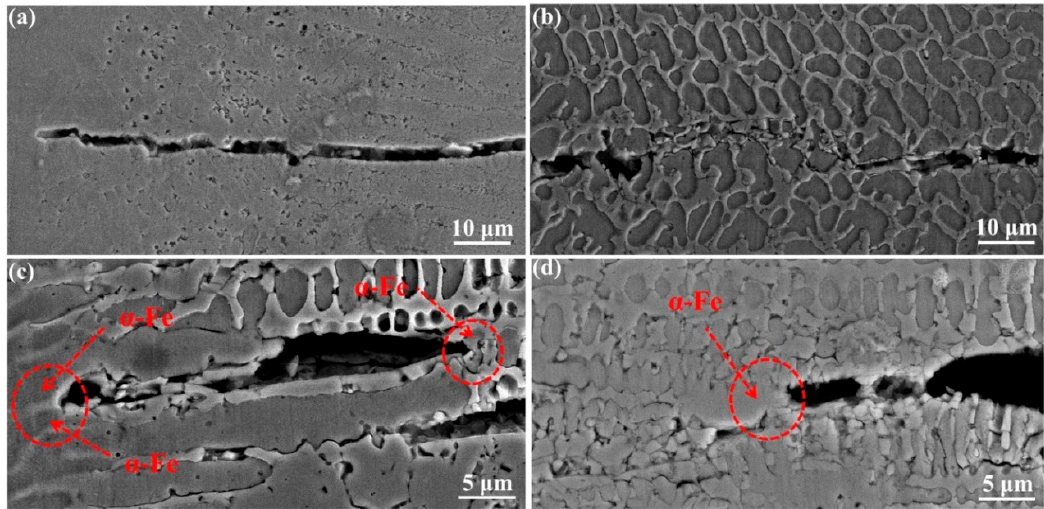
Figure 8. SEM images of crack initiation patterns with different volume fraction of α‐ Fe phase: ( a ) Sample A, ( b ) Sample B, ( c ) Sample C and ( d ) Sample D. ( a ) Sample A, ( b ) Sample B, ( c ) Sample C and ( d ) Sample